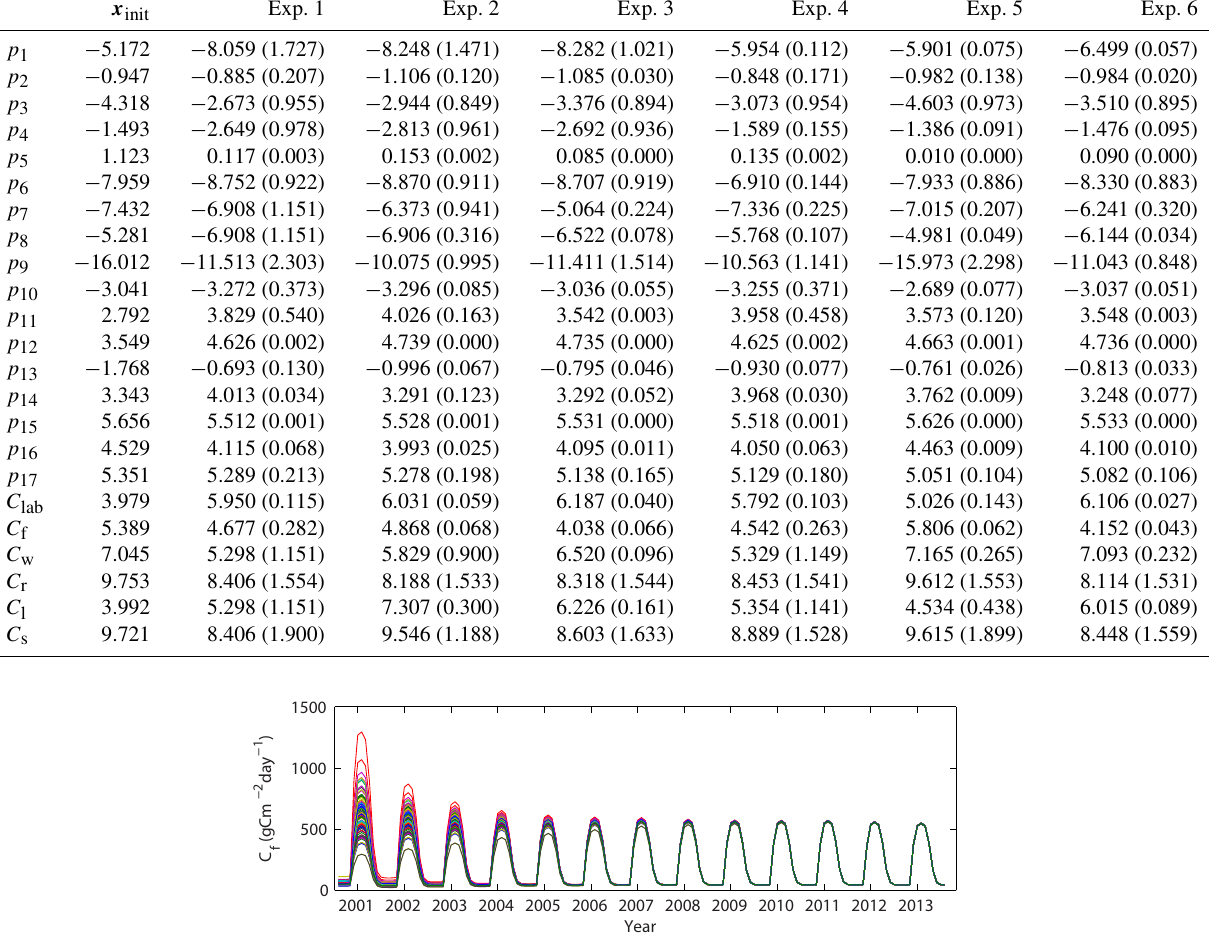
Table 5. Results of the inverse modelling experiments. The solution components together with their relative variance, in brackets, are given for each experiment. The vector x init is the randomly chosen parameter set satisfying the EDCs that initialises the minimisation routine.